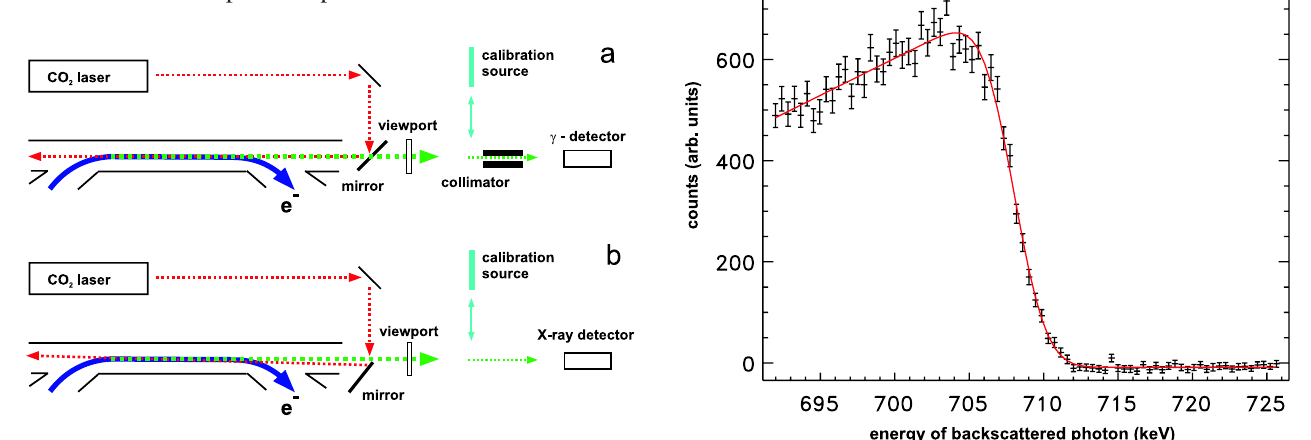
FIG. 3. (Color) Schematic setup of the instrumentation for the measurement of the electron beam energy for high (a) and low (b) electron beam energy values.